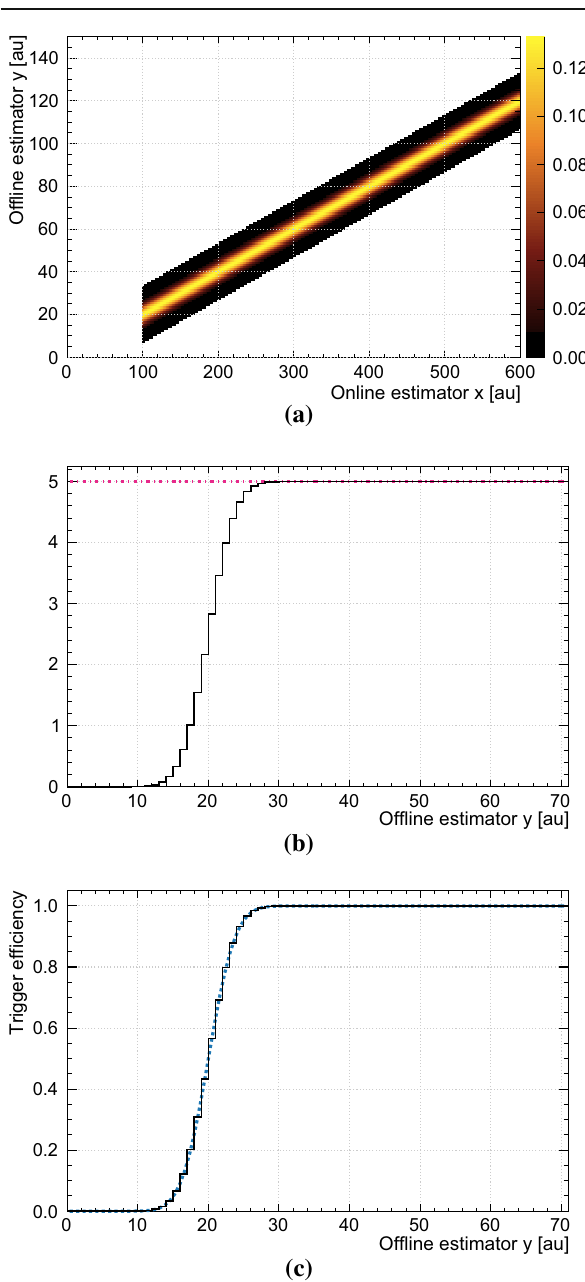
Fig. 3 The Gaussian example (Eq. (2)) for a = 0 . 2, σ = 3. a The distribution of x versus y . b The y-profile (black line), together with the calculated level of the plateau (pink dashed). c The profile scaled by the plateau height (black), which represents the trigger efficiency. The blue dashed line is a step function convoluted by a Gaussian, with function parameters taken at the trigger threshold